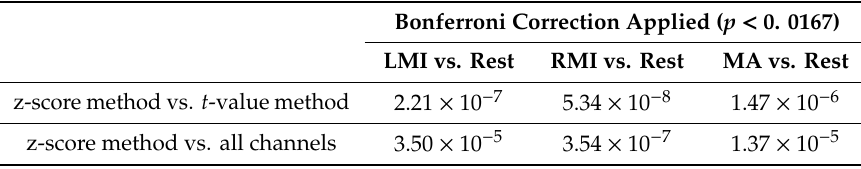
Table 2. Statistical significance of the z-score